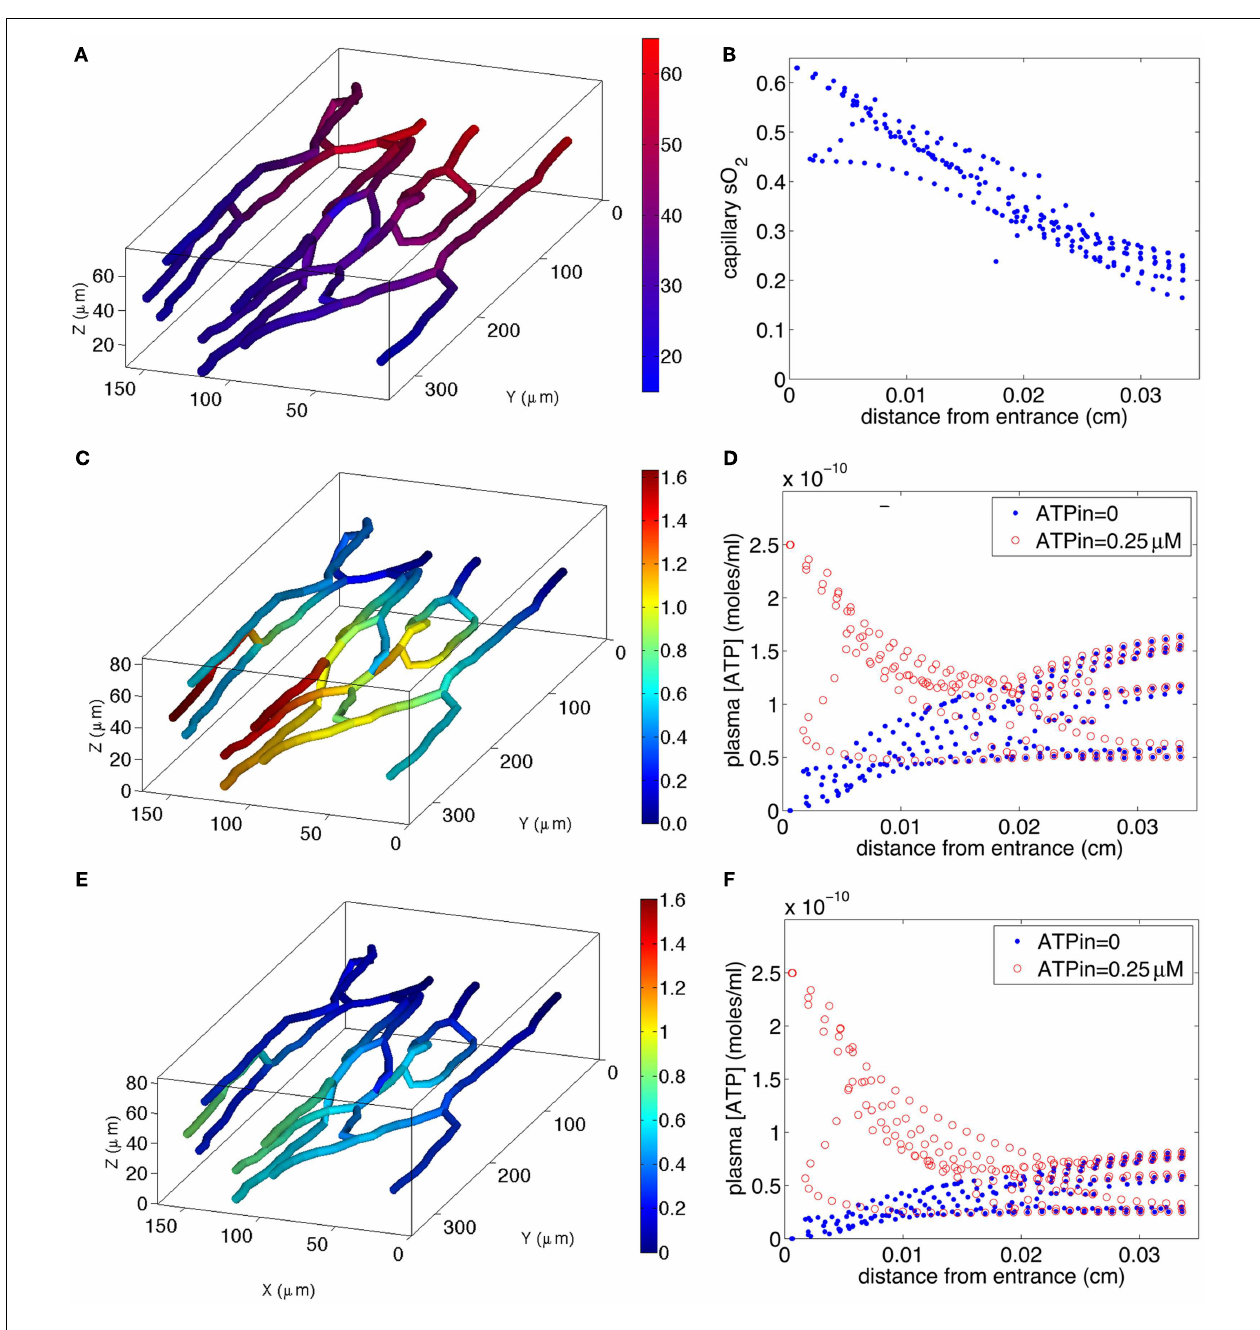
calculated ATP distribution for impaired ATP release due to increased plasma insulin [ (E) , left] in 3D network with ATP in = 0 and [ (F) , right) as a function of z for ATP in = 0 and ATP in = 0.25 µ M.The color bar in (A) indicates the variations in sO 2 (17–63%) in the 3D capillary network, while the color bars in (C,E) indicate the variations in [ATP] [0–1.6 µ M in (C) and 0–0.8 µ M in (E) ] in the